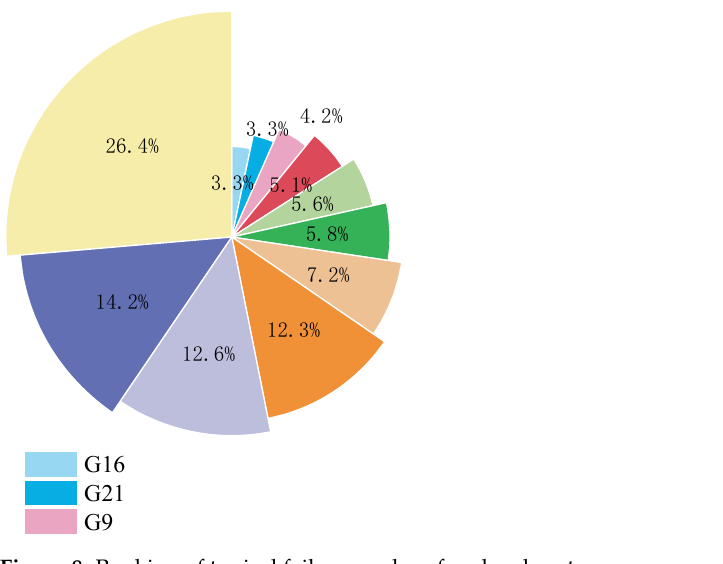
Figure 8. Ranking of typical failure modes of each subsystem.